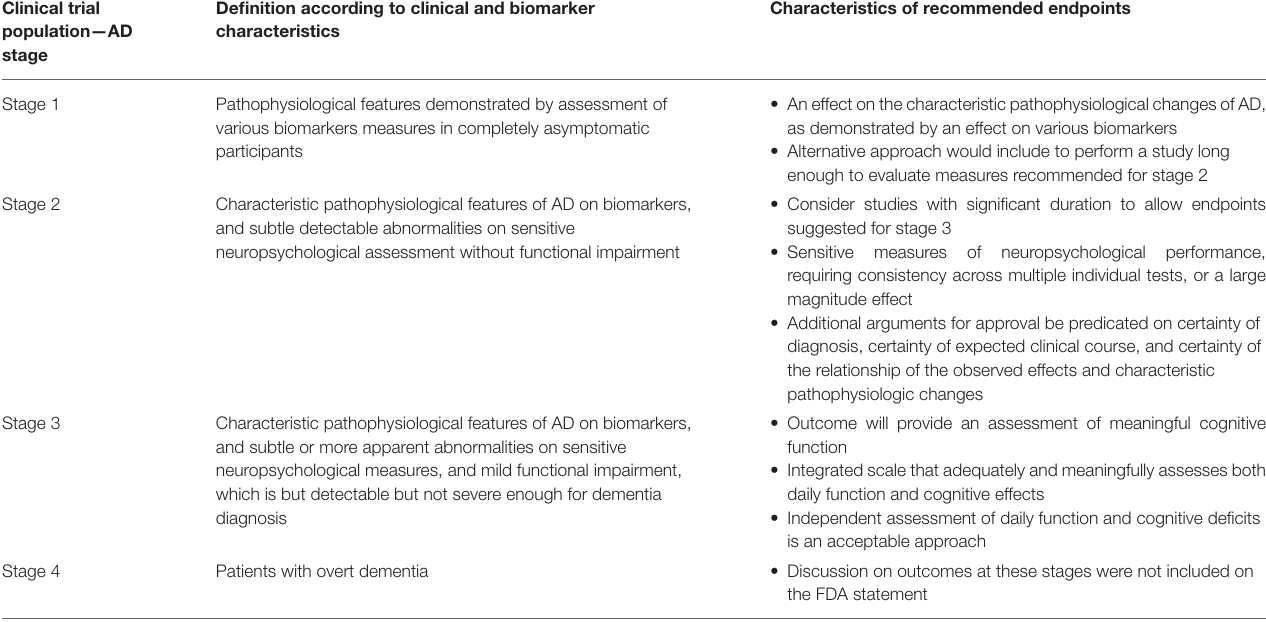
TABLE 3 | FDA suggestions for endpoints in clinical trials for early AD. Clinical trial